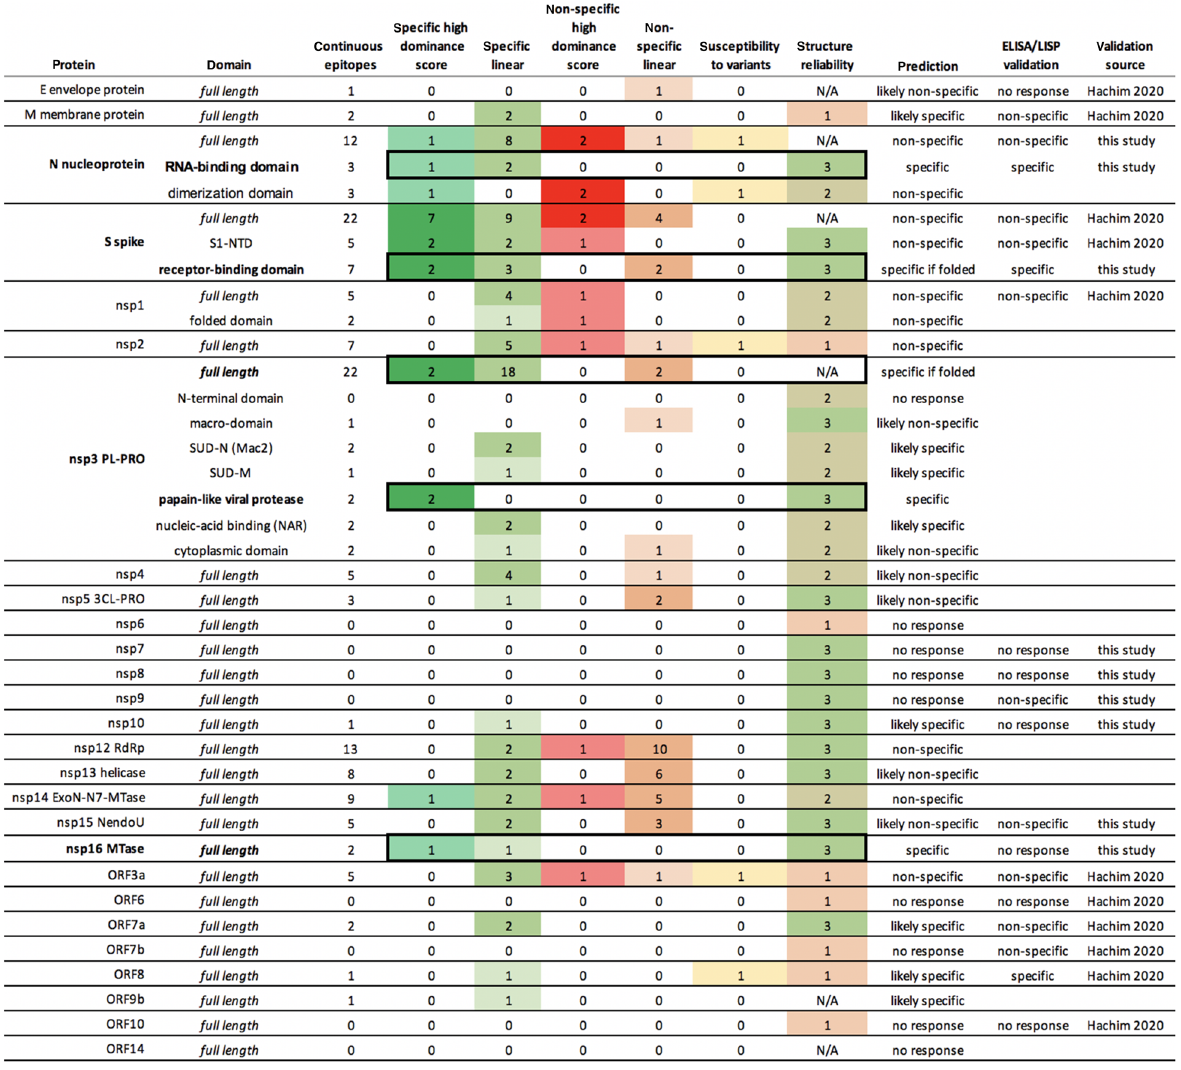
Table 1. Summary predictions of SARS-CoV-2 diagnostic candidates, with the numbers of predicted epitopes in each category. Flexible segments are classified as having a high dominance score. Susceptibility to variants indicates the presence of epitopes with conserved mutations or a variant density above 80%. Structure reliability is set to 3 for experimental structures (very reliable), 2 for homology models and 1 for de-novo models (unreliable). Top five candidates are highlighted with a black